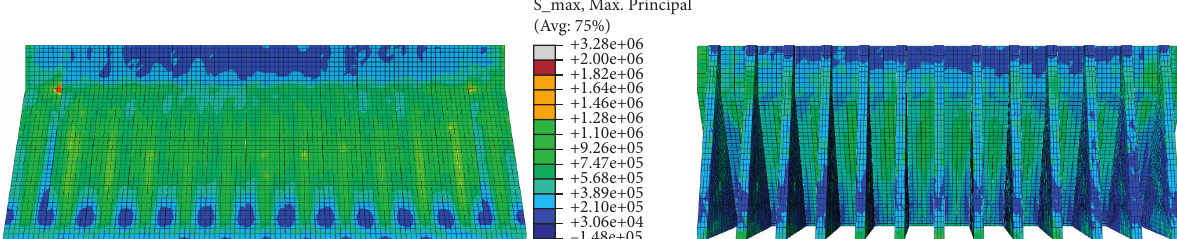
Figure 22: Maximum envelope of maximum principal stresses at upstream and downstream sides of the buttress dam with all components of the Swedish design earthquake considered.